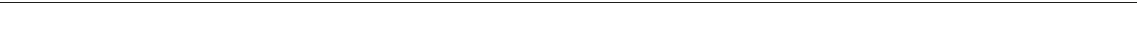
Fig. 3 H19 overexpression protects from obesity by increasing energy expenditure and scWAT beiging. a Body weight of HFD-fed Control ( n = 4 – 5) versus H19 TG ( n = 4 – 5) mice. A 2WA-RM with Bonferroni post hoc correction for multiple comparisons (2WA-B) was applied to assess signi fi cance. b Insulin tolerance test of HFD-fed Control ( n = 4) versus H19 TG ( n = 6) mice. c Glucose tolerance test of HFD-fed Control ( n = 5) versus H19 TG ( n = 5) mice. d Energy expenditure in HFD-fed Control ( n = 4) versus H19 TG ( n = 5) mice. b – d A 2WA-B was applied to assess signi fi cance. e Respiratory Exchange Ratios (RER) in HFD-fed Control ( n = 4) versus H19 TG ( n = 5) mice. f Tissue/body weight (BW) ratios in HFD-fed Control ( n = 4) versus H19 TG ( n = 5) mice. An unpaired, two-tailed Student ’ s t-test was applied to assess signi fi cance. g Serum cholesterole levels in HFD-fed Control ( n = 4) versus H19 TG ( n = 5) mice. h Serum triglyceride levels in HFD-fed Control ( n = 4) versus H19 TG ( n = 5) mice. An unpaired, two-tailed Student ’ s t -test was applied to assess signi fi cance. i Representative photomicrograph of BAT from HFD-fed Control versus H19 TG mice. j Automated quanti fi cation of adipocyte mean area per fi eld in hematoxylin/eosin (HE) stained BAT sections from HFD-fed Control ( n = 12 fi elds) versus H19 TG ( n = 9 fi elds). An unpaired, two-tailed Student ’ s t -test was applied to assess signi fi cance. k Automated quanti fi cation of adipocyte mean area in HE-stained scWAT sections from HFD-fed Control ( n = 12 fi elds) versus H19 TG ( n = 16 fi elds) mice. l Automated quanti fi cation of adipocyte mean area in HE-stained vWAT sections from HFD-fed Control ( n = 8 fi elds) versus H19 TG ( n = 10 fi elds) mice. An unpaired, two-tailed Student ’ s t -test was applied to assess signi fi cance. m Representative photomicrograph of vWAT sections from HFD-fed Control versus H19 TG mice. n Representative photomicrograph of liver sections from HFD-fed Control versus H19 TG mice. m , n Scale bar, 50 µ m. o scWAT expression of indicated mRNAs from HFD-fed Control ( n = 4) versus H19 TG ( n = 5) mice. p Relative BAT expression of indicated mRNAs from HFD-fed Control ( n = 4) versus H19 TG mice ( n = 3). An unpaired, two-tailed Student ’ s t -test was used to assess signi fi cance in o , p . * p < 0.05, ** p < 0.01, *** p < 0.001. If applicable p -values are indicated within the